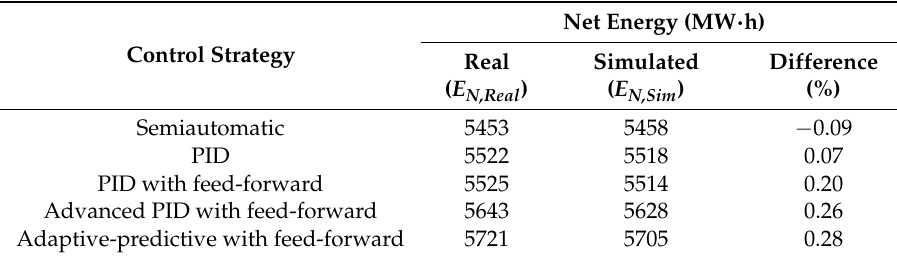
Table 5. Net Energy Produced After 17